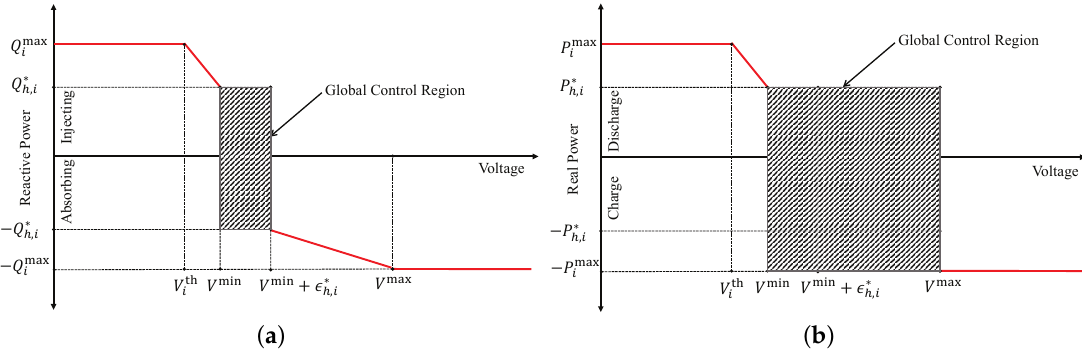
Figure 2. CVR-based piecewise droop control functions for the inverters of the photovoltaic (PV) systems and energy storage systems (ESSs): ( a ) Volt–VAR curve; ( b ) Volt–Watt